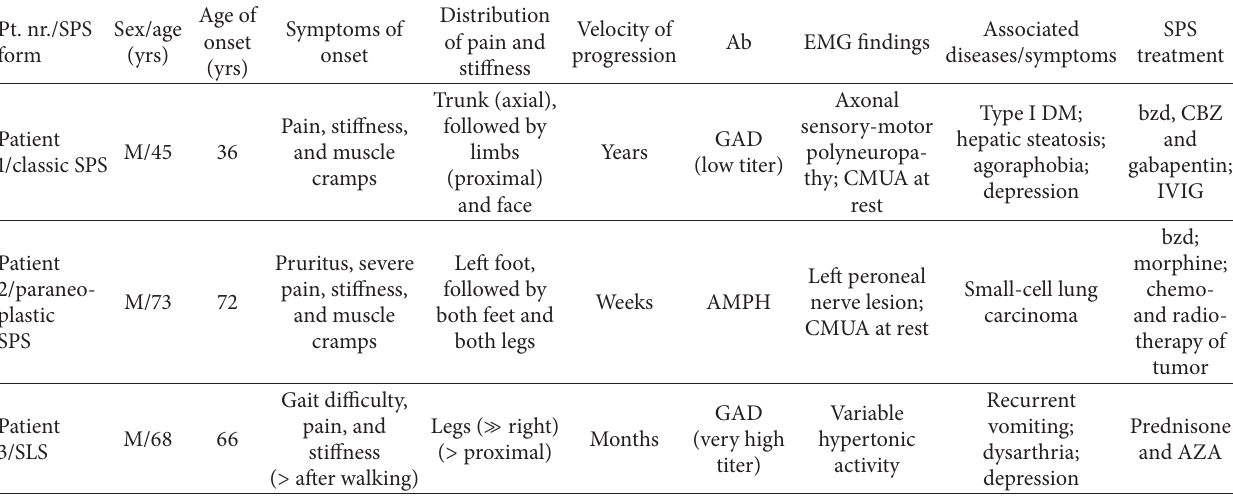
Table 1: Main characteristics of the three SPS